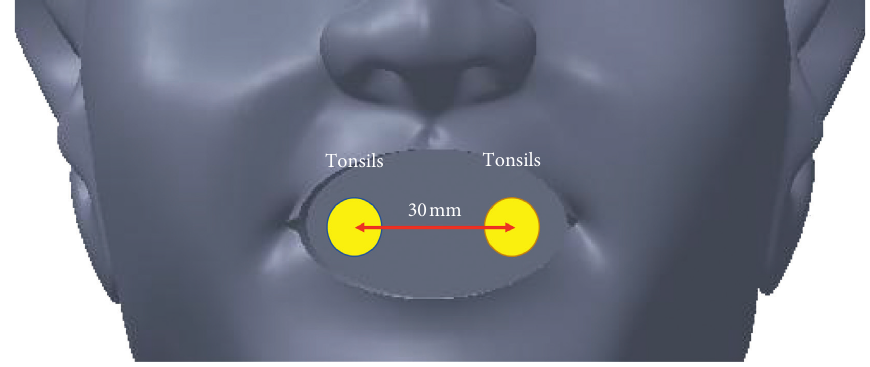
Figure 3: Schematic diagram of the definition of the tonsil in the oral cavity.